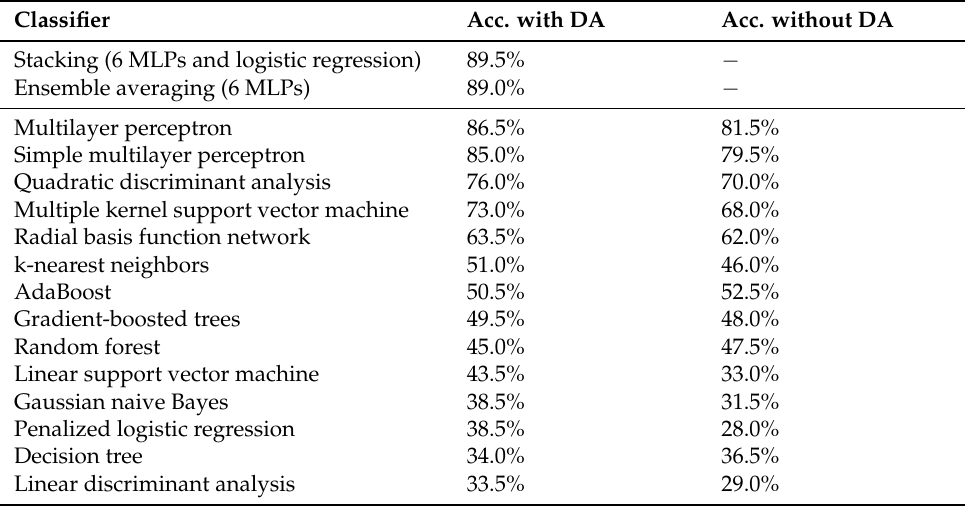
Table 2. Test accuracies of different classifiers with dimensionality reduction by principal component analysis (PCA), with and without data augmentation (DA).